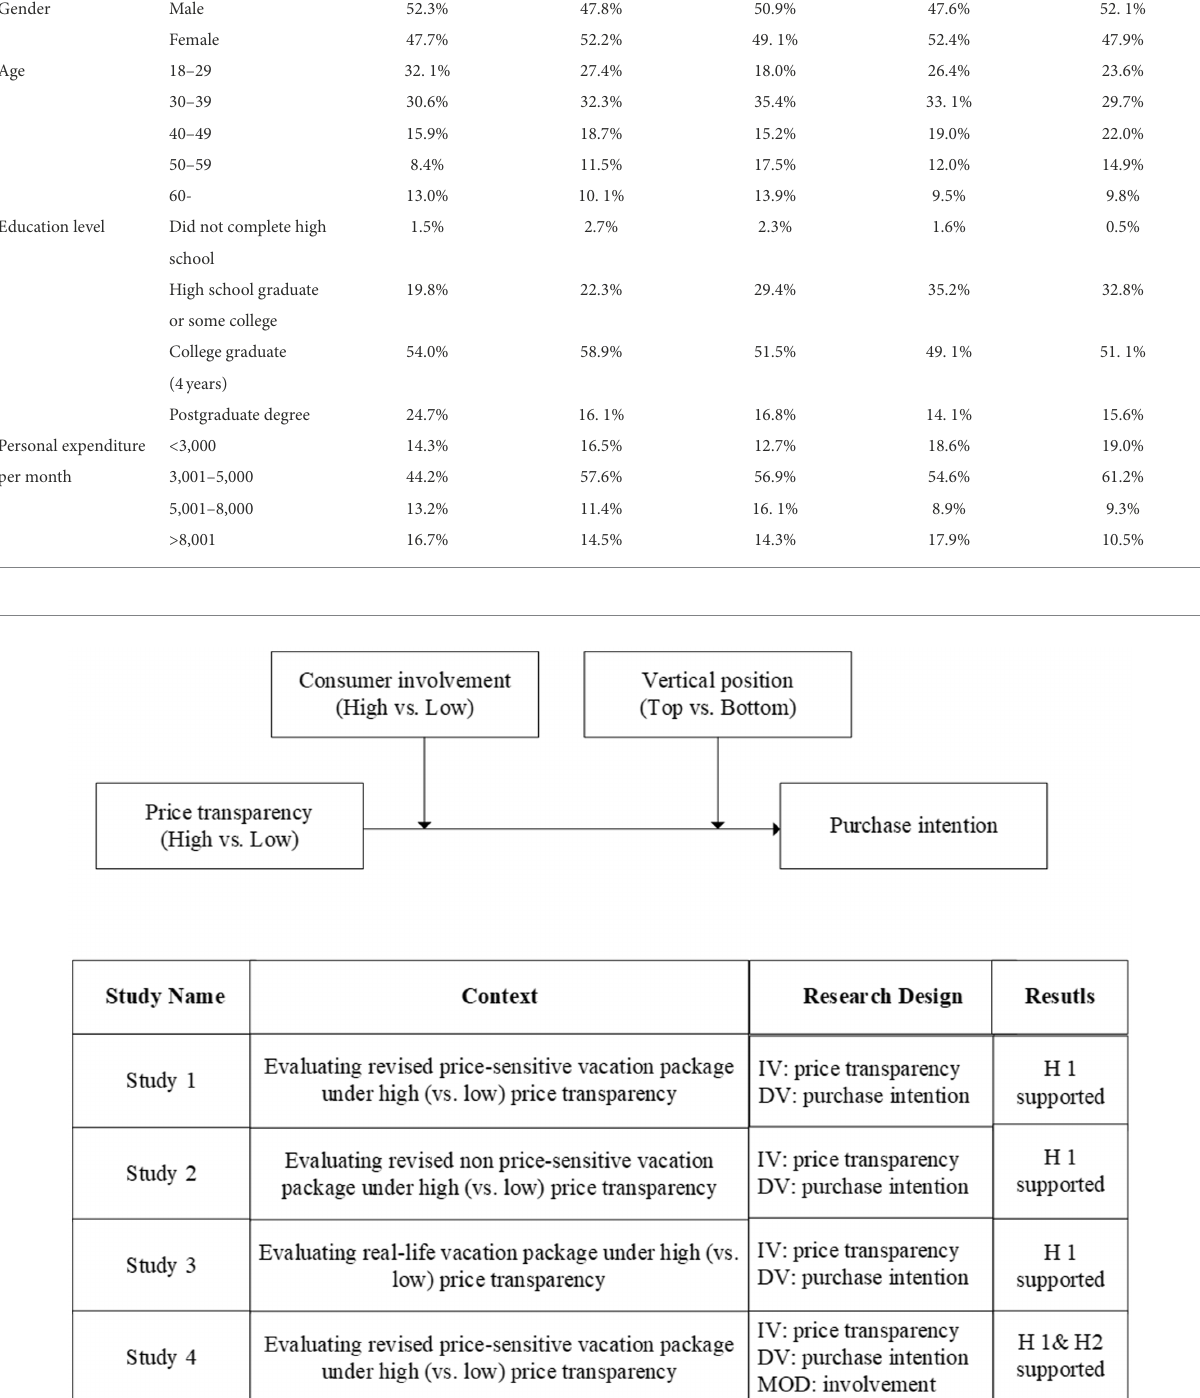
TABLE 1 Profiles of participants in studies 1–5.